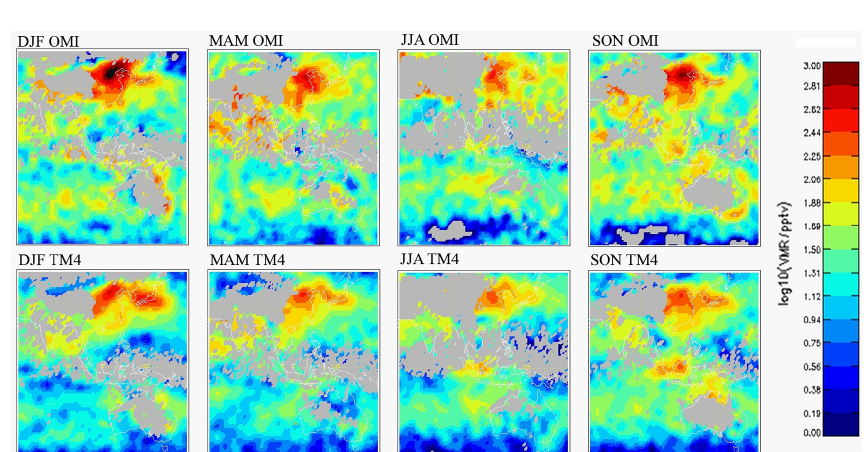
Figure 27. Same as Fig. 24 but at 620hPa.